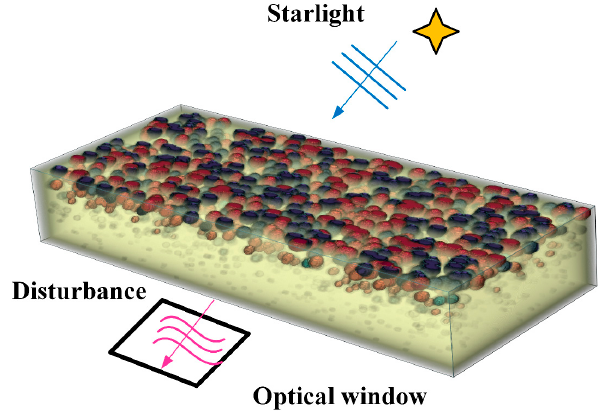
Figure 1. Schematic diagram of boundary layer density proxy model.